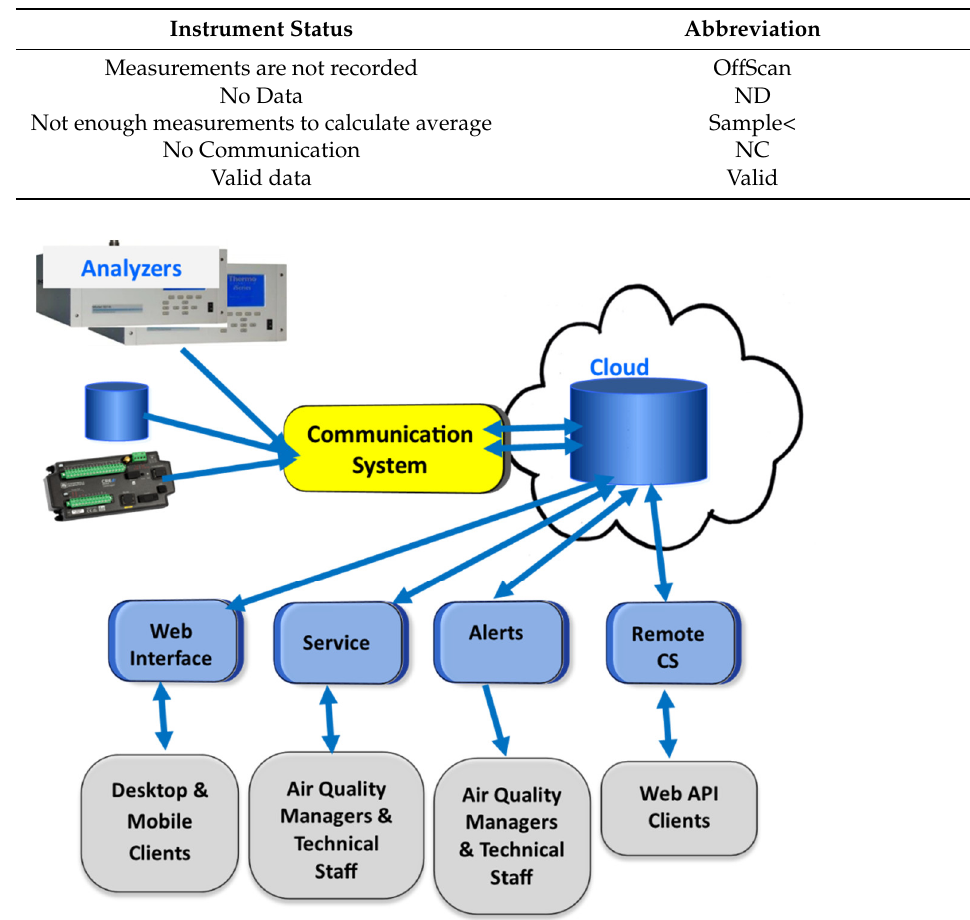
Table 1. Abbreviation status explanation (flags).